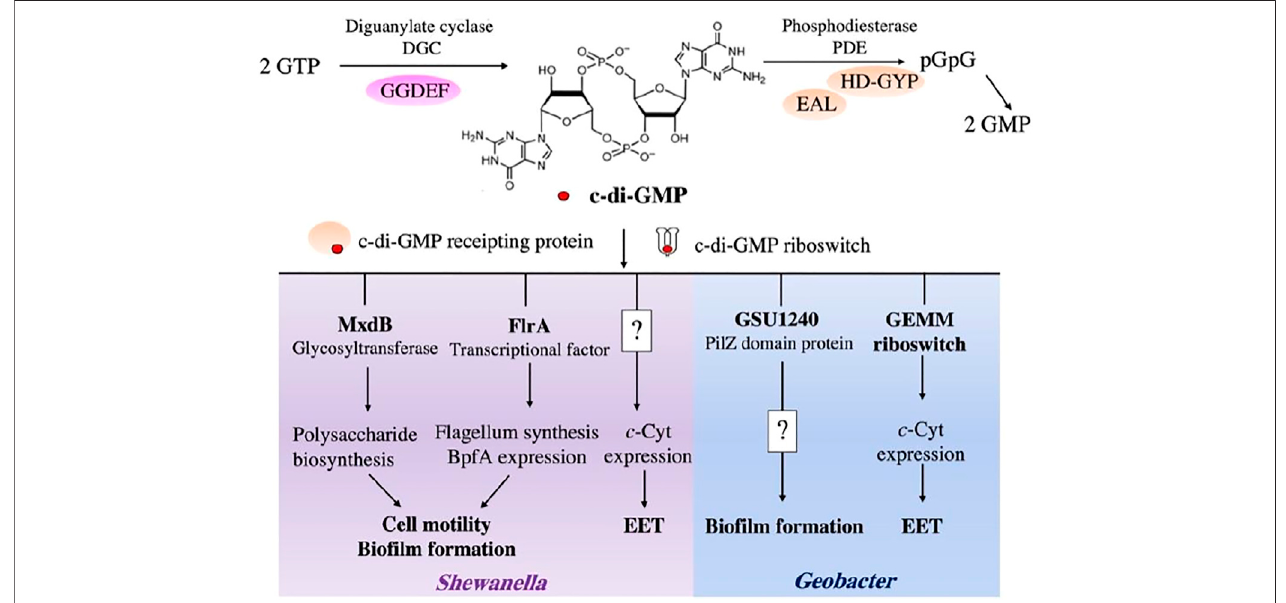
FIGURE 3 | c-di-GMP signaling in Shewanella and Geobacter cells. The intracellular level of c-di-GMP is mediated by DGCs with GGDEF domains and PDEs with EAL/HD-GYPdomains.In Shewanella spp.,thec-di-GMPsignalingnetworkcoordinatesthebiosynthesisofextracellularpolysaccharidesthroughinteractionwithMxdB glycosyltransferase, a polysaccharide biosynthetic enzyme. Flagellum synthesis and BpfA expression are controlled by c-di-GMP through its responsive transcriptional factor, FlrA. c-di-GMP also positively regulates c -cytochrome ( c -Cyt) expression in S. oneidensis MR-1, but molecular mechanism is unclear. In Geobacter spp., c-di-GMP regulates bio fi lm formation and c -Cyt expression using PilZ domain-containing protein and GEMM riboswitches, respectively. How c-di-GMP regulates formation of Geobacter bio fi lm is currently unknown.